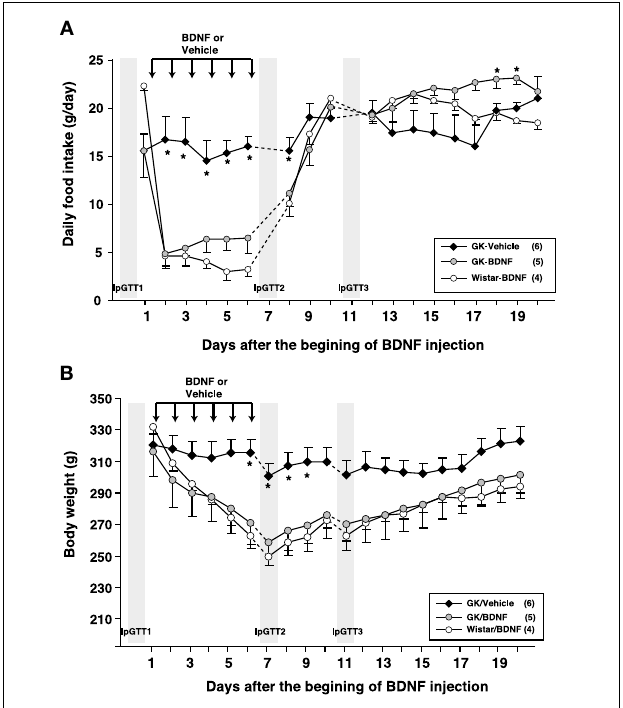
FIGURE 5 | Effect of BDNF treatment on food intake and body weight in GK rats. (A) Daily food intake was examined before and after BDNF treatment (15 μ g/5 μ l saline/head) for 6 days. BDNF treatment significantly reduced daily food intake during period of treatment in both GK-BDNF and Wistar-BDNF groups. ∗ p < 0 . 05 vs. other groups (One-Way ANOVA with Holm’s post-hoc test). (B) Body weight was examined before and after treatment of BDNF for 6 days. BDNF treatment significantly reduced body weight in both GK-BDNF and Wistar-BDNF groups. ∗ p < 0 . 05 vs. other groups (One-Way ANOVA with Holm’s post-hoc test).